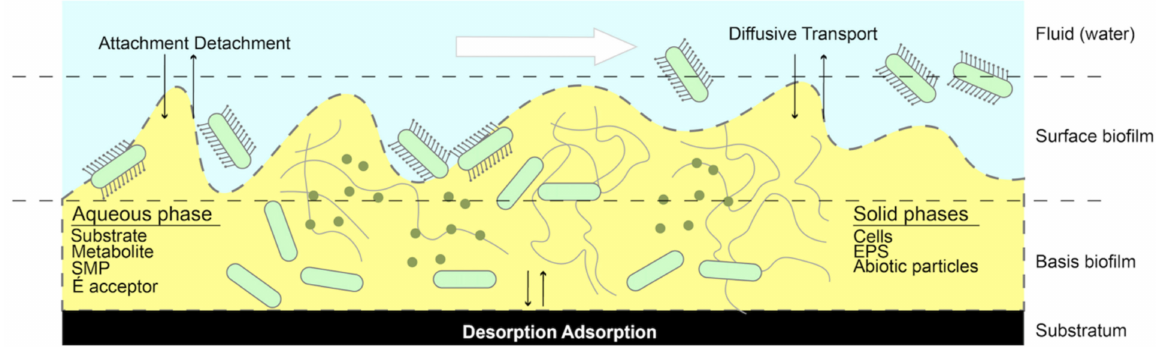
Figure 1. Schematic diagram of biofilm development in the material surface of piping